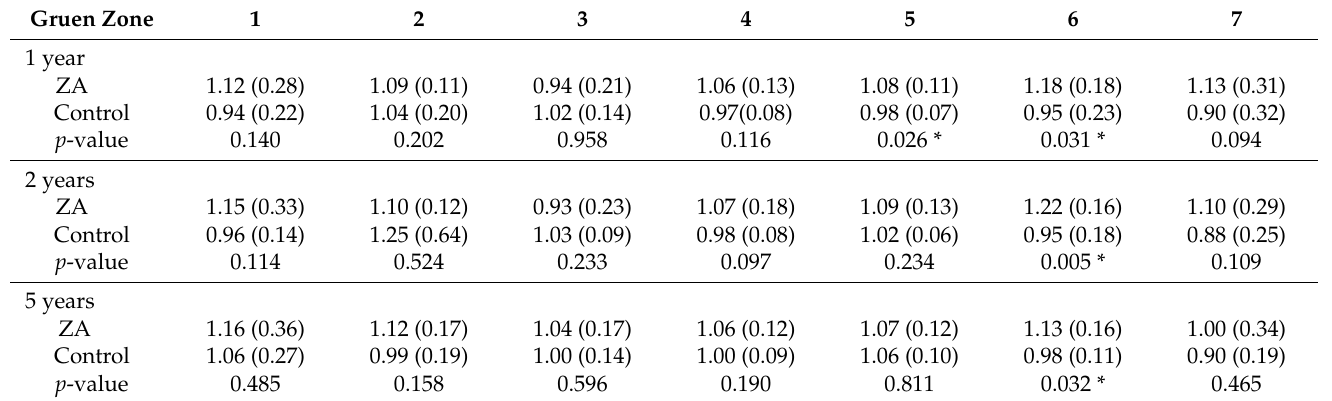
Table 4. Mean BMD Change Ratios by Gruen zone for ZA ( n = 9) and control ( n =